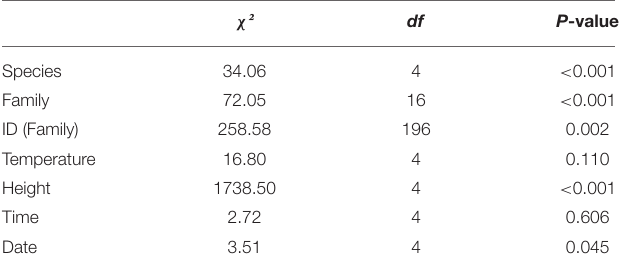
TABLE 4 | Results of the multinomial logistic regression to investigate variation in microhabitat use between the two species during the hibernation experiment ( n = 1,750).